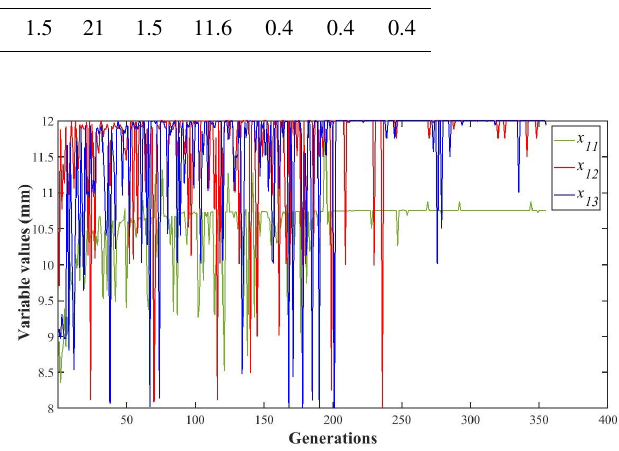
Figure 15. Variations of the design variables under different num- bers of generation.